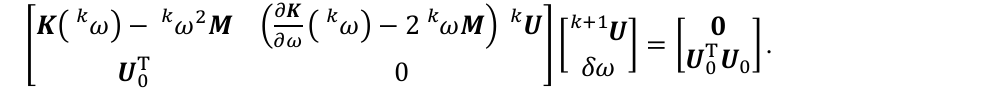
Table 2: Quasi-static analysis: Comparison of experimental data and numerical predictions corresponding to the largest loading